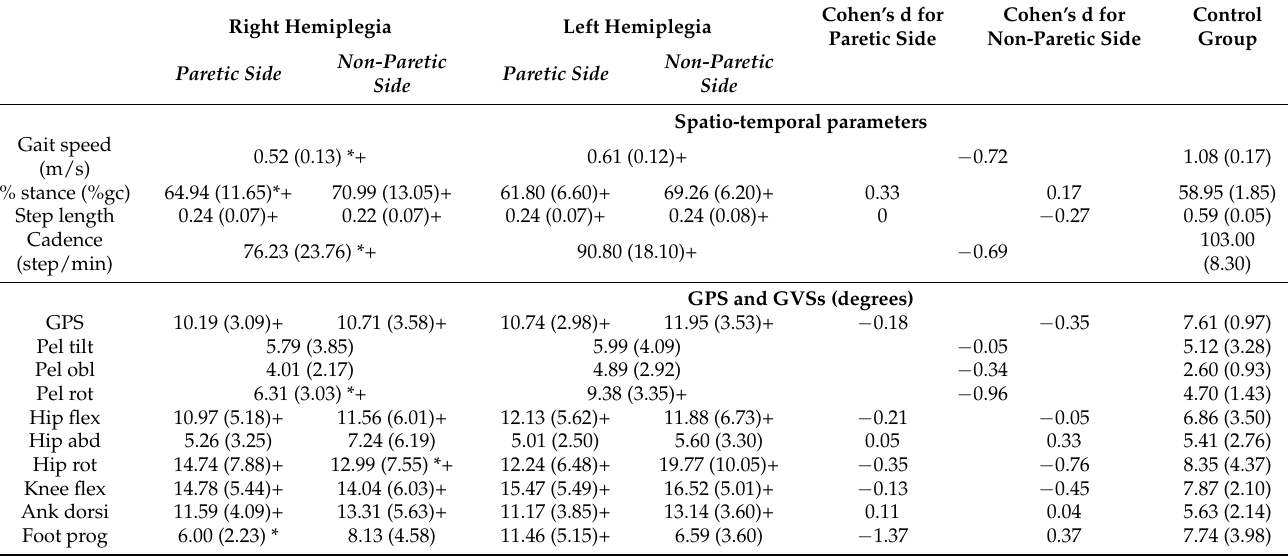
Table 2. Mean and standard deviation values of analysed parameters (spatio-temporal parameters, GPS and its GVSs) for the paretic and non-paretic side of the right and left hemiparetic group and the control